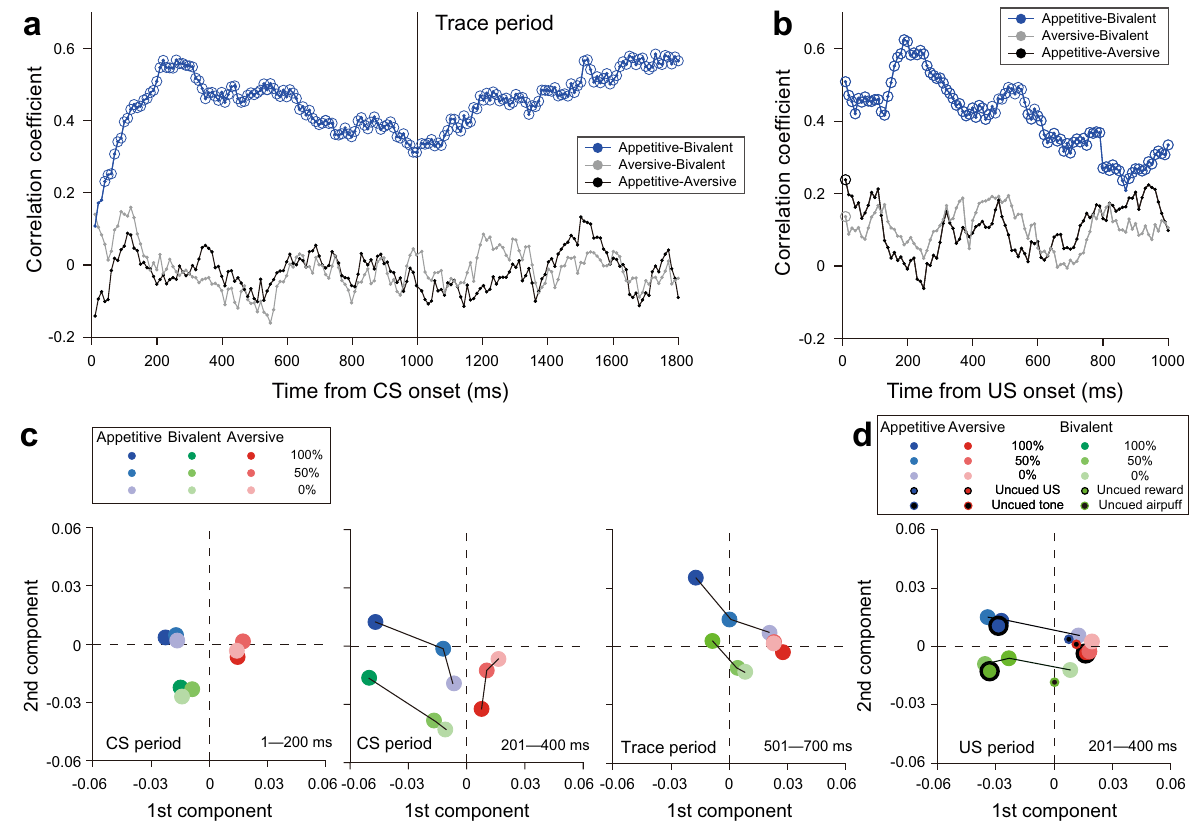
Figure 5. Consistent activity throughout a trial between the appetitive and bivalent blocks. ( a, b ) Consistent conditioned stimulus (CS) value-coding during CS and trace periods ( a ) and outcome predictability coding ( b ). Each dot represents the correlation coefficient between the appetitive and bivalent blocks (blue), between the aversive and bivalent blocks (gray), and between the appetitive and aversive blocks (black) at the population level. Spearman’s correlation test was applied in each test window with a 200-ms duration moving in 10-ms steps. The circles represent statistical significance ( p < 0.05). Dots and circles were aligned at the initial time point of the test window. All neurons were used for the calculation. US, unconditioned stimulus. ( c ) Clear differentiation among trial types and blocks in the principal component feature space (1–200 ms after CS onset, left ; 201–400 ms after CS onset, center ; 501–1,000 ms after trace onset, right ). For feature-space production, the first and second components of principal component analysis (PCA) were used. Data used in PCA were the two-dimension matrix of all neurons ( n = 244) × averaged firing rates of 540 bins in total in the 100% and 0% trial types during the appetitive-bivalent, and aversive blocks (90-time bins × 2 trial types × 3 blocks). Each bin had a 100-ms duration and moved from CS onset to the end of the trace without overlap for each block. Black lines linking cue-trial types in the same block were added for better recognition. ( d ) Valid representation of uncued and cued outcome values in the principal component feature space. Despite using only the CS and trace activity in the 100% and 0% trials, the feature space well represents the values of the uncued outcomes: large blue, green, and red circles with the black edge depict free reward in the appetitive block, free reward in the bivalent block, and free airpuff in the aversive blocks, respectively; small black dots with the blue, green, and red edges illustrate free tone in the appetitive block, free airpuff in the bivalent block, and free tone in the aversive blocks,